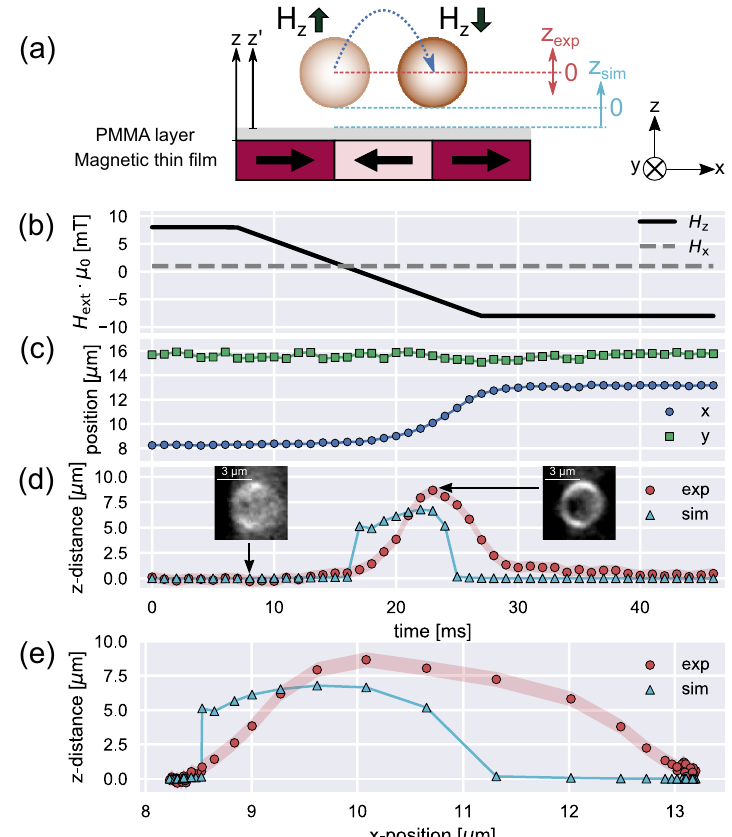
Figure 3. 3D analysis of transport dynamics for 4 µm sized SPPs within a dynamically transformed MFL. ( a ) Sketch of one transport step for the SPP above a hh/tt magnetic stripe pattern (black arrows) after changing the external magnetic field in z -direction. The blue arrow indicates the expected “hopping” like motion of the SPP. Reference positions for the normalization of the experimentally determined vertical movement ( z exp ) and the theoretically estimated equilibrium distance ( z sim ) are indicated. Relevant forces for the estimation of z sim were calculated along the indicated vertical axes z and z’ (see Supporting Information S5). ( b ) Applied external magnetic fields as a function of time for one pulse sequence. Black solid line: field in z -direction, grey dashed line: field in x -direction. ( c ) Plot of an exemplary SPP trajectory: determined x - (blue circles) and y - (green squares) SPP-center coordinates as functions of time. ( d ) Experimentally determined z -SPP center coordinates, relative to the equilibrium position of the SPP before the z -field change, superposed on the lateral movement (red circles). The initial z -position before the z -field change has been normalized to zero. Red shaded areas indicate the fit uncertainty for the used z -coordinate calibration function. For comparison, theoretical equilibrium distances between SPP and the substrate surface were computed (cyan triangles). The insets show background-subtracted microscopic images of the SPP at the indicated time. Changes in SPP sharpness and thereby z -position are observable. ( e ) Plot of determined z -positions in dependence on the x -positions for an SPP during a transport step. Again, red circles represent normalized experimental data (with the red shaded area as the uncertainty), while the cyan triangles depict simulated equilibrium distances. The data normalization was performed as described for ( d ). Data points of x -, y -position, and the simulated z -distance were connected to provide a guide to the